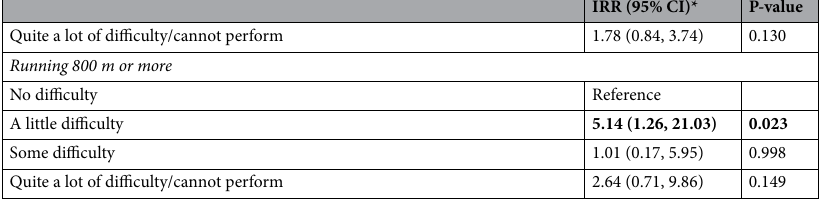
Table 2. Relationship between baseline individual items of lower extremity function (basic and advanced) and incident falls. IRR incidence rate ratio, CI confidence interval. *Adjusted for age, gender, ethnic group, living arrangement, hypertension, polypharmacy, nutritional status, self-reported depression, stroke, osteoarthritis, osteoporosis, vision/hearing impairment, and dementia. Bold values are statistically significant for P-value ≤ 0.05.